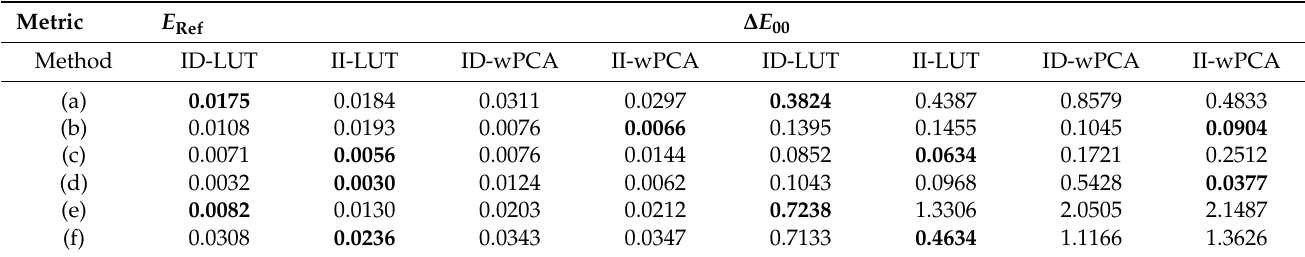
Table 2. The E Ref and ∆ E 00 values for the cases shown in Figure 11a–f. The best values are shown in bold.